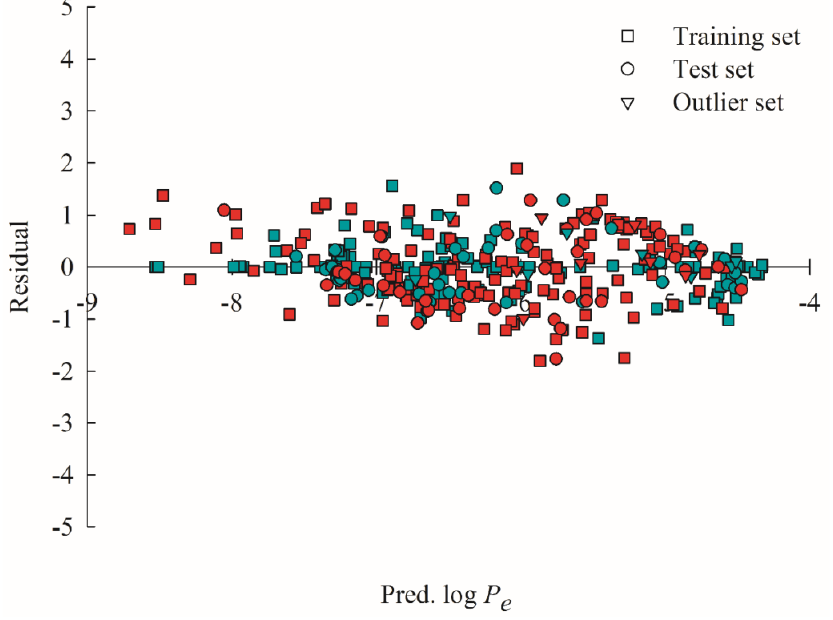
Figure 6. Residual vs. the log P e predicted by HSVR (green) and PLS (red) in the training set (square), test set (circle), and outlier set (triangle).